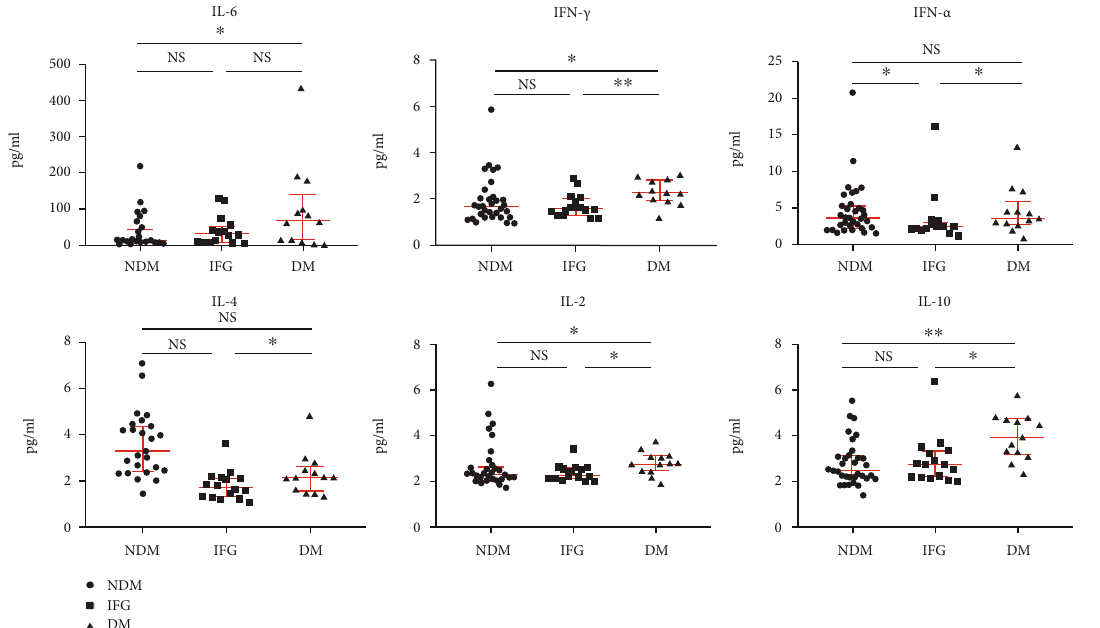
Figure 1: The cytokines levels among the NDM, IFG, and DM groups. NDM: nondiabetes mellitus; IFG: impaired fasting glucose; DM: diabetes mellitus. ∗ P < 0 : 05 and ∗∗ P < 0 : 005 . Black circle=NDM group ( n = 33 ); black square =IFG group ( n = 16 ); black triangle=DM group ( n = 13 ). Because the cytokines levels of 9 patients were not performed, data of 62 patients were